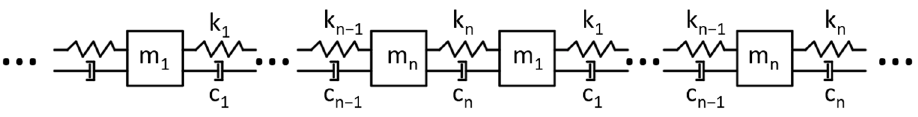
Figure 1. Dynamic Model of Infinite Periodic Structures.